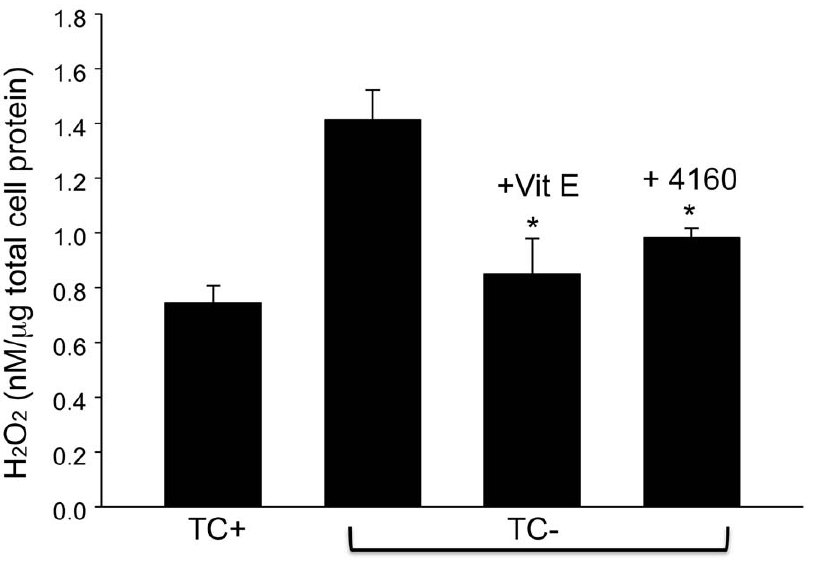
Figure 12. Cultured neuronal cells treated with SLF HO-4160 decrease production of hydrogen peroxide. MC65 cells were cultured in the presence (TC + ) or absence (TC 2 ) of tetracycline, a transgene suppressor of the APP fragment C99. In the absence of tetracycline, cells express the C99 fragment which is then further cleaved to form A b . Treatment with either the HO-4160 compound ( + 4160, 0.3 m M) or the antioxidant vitamin E ( + Vit E, 100 m M) reduces the extracellular accumulation of hydrogen peroxide in cells expressing APP-C99. Error bars represent the SEM for N=3. *p , 0.05 TC 2 compared to both + Vit E and + 4160.